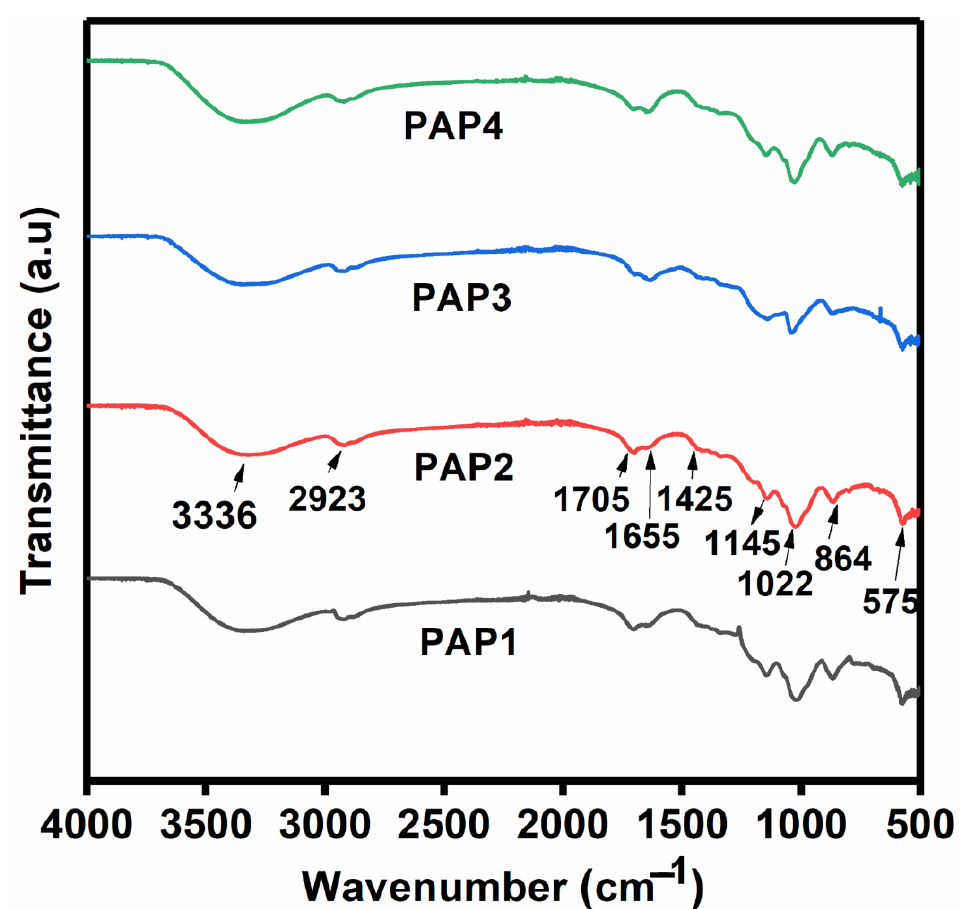
Figure 6. FTIR spectra of the synthesized all-in-one hydrogels.